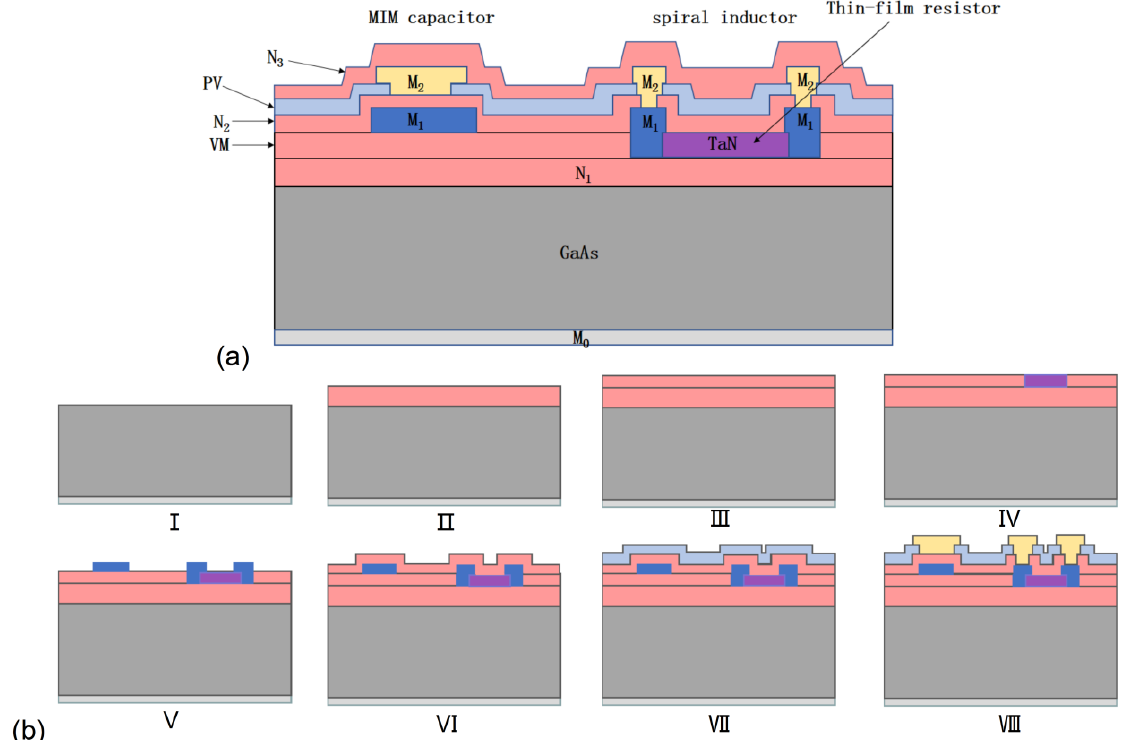
Figure 2. Structure schematic and major fabrication steps of GaAs IPD process. ( a ) Structure schematic (cross-section) of GaAs IPD process. ( b ) Steps of GaAs IPD process. I. GaAs substrate with M 0 layer (Au). II. N 1 layer (Si 3 N 4 ) was deposited on GaAs substrate. III. VM layer (Si 3 N 4 passivation) was deposited. IV. TaN was deposited for thin-film resistor. V. M 1 layer (Au) was deposited. VI. N 2 layer (Si 3 N 4 ) was deposited as dielectric layer. VII. PV layer (polyimide) was deposited between M 1 layer and M 2 layer. VIII. M 2 layer (Au) was deposited.